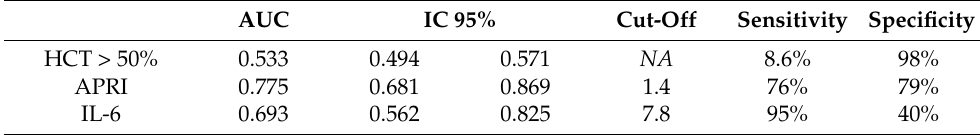
Figure 2. Cytokines/chemokines and coagulation mediator profiles in dengue patients. PCA biplot shows the two principal components that represent a cumulative percentage of variance of 80.8%, PC1 (45.1%): TNF- α , IL-1 β and PC2 (35.7%): IL-6, TF and TFPI. Individual scores for each PC are represented as colored points that are grouped according to WHO 2009 classification. (Ellipses represent 95% confidence interval for each group). Loadings of variables are represented as arrows; the length of each arrow represents the contribution of each variable on each principal component. Table 3. AUC values obtained from ROC analysis for biomarkers associated with